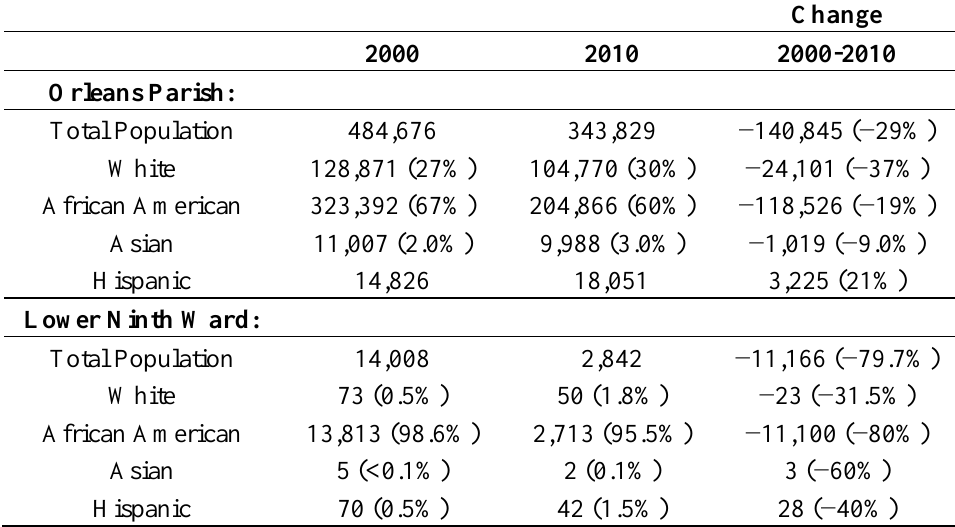
Table 3. Total population and ethnic/racial population for New Orleans and the Lower Ninth Ward,